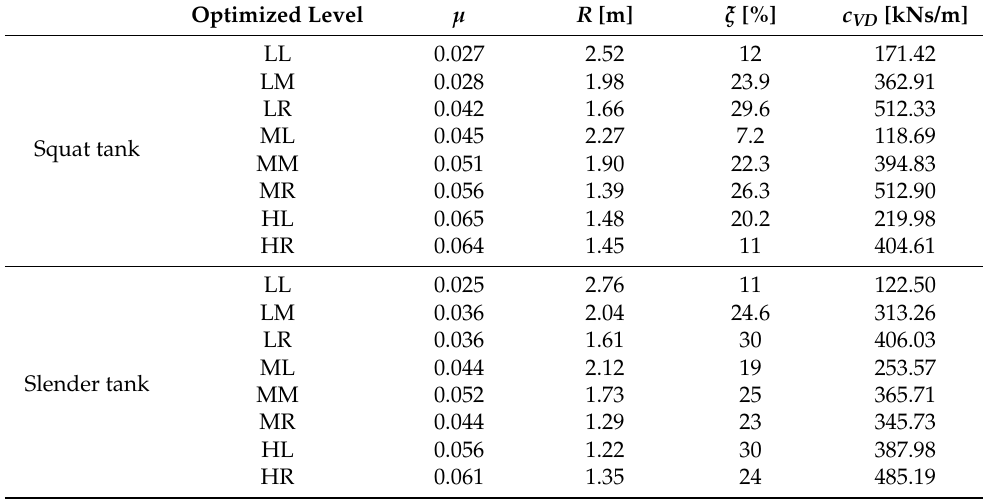
Table 4. Optimization results for the selected solutions of the MOGA2 approach.